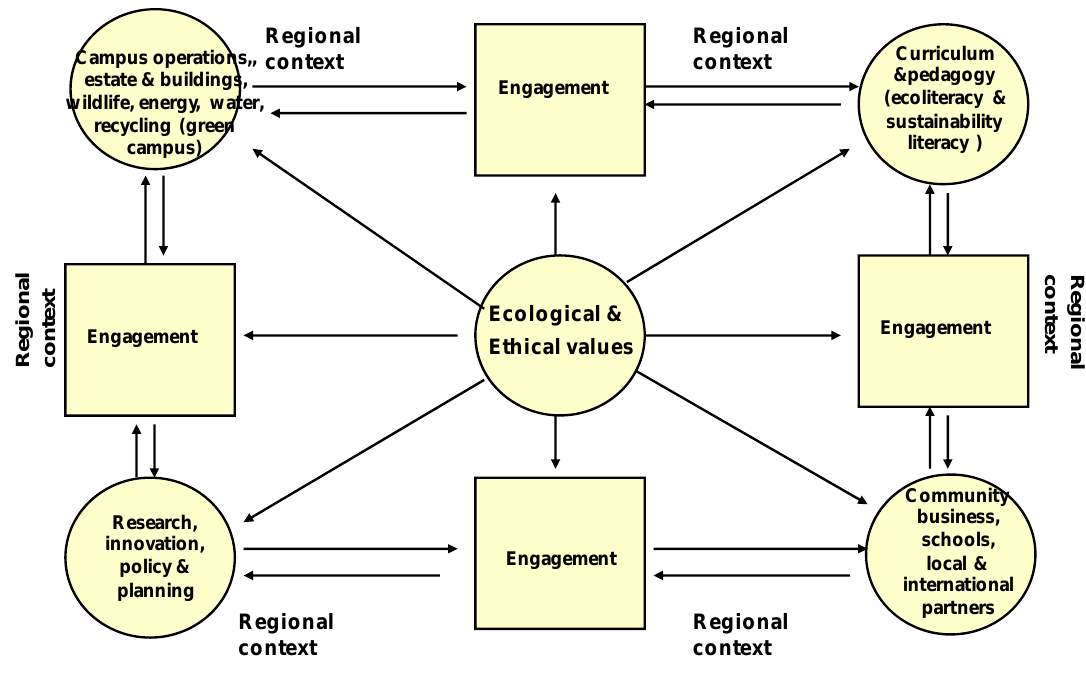
Figure 1. Ecoversity schematic